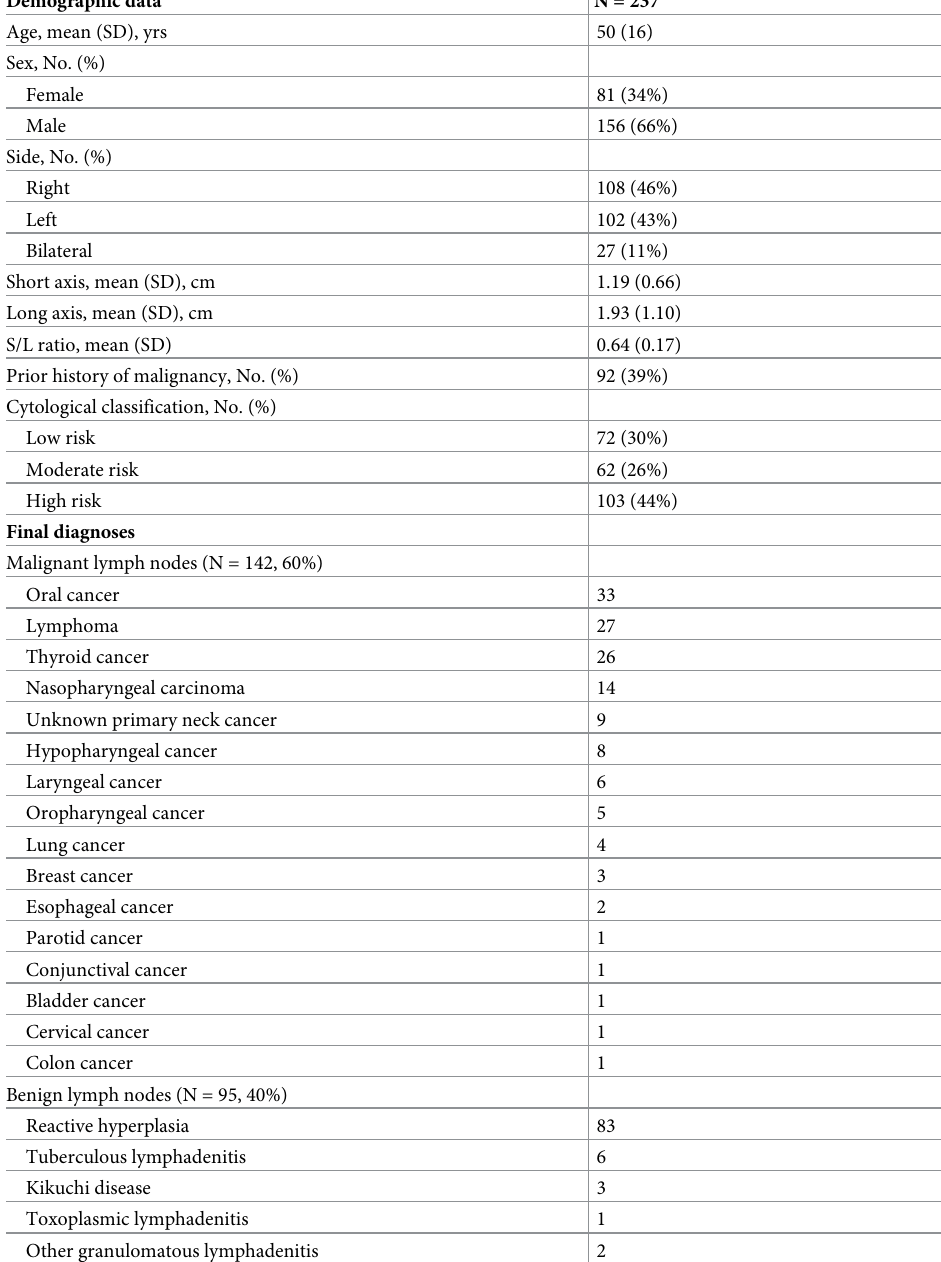
Table 1. Demographic data of the patients who had neck LNs with indeterminate cytology. Demographic data